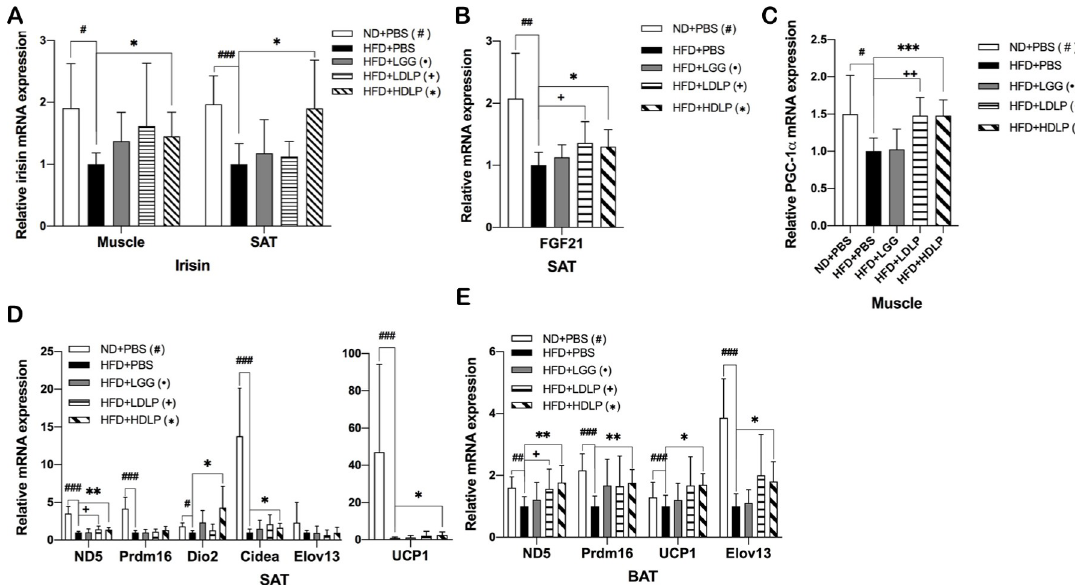
Fig 3. L . plantarum treatment induces browning and non-shivering thermogenesis. Effects of L . plantarum treatment on mRNA expression of (A) irisin in skeletal muscle, (B) FGF21 in SAT, (C) PGC-1 α in skeletal muscle, and (D-E) genes involved in browning and thermogenesis in SAT and BAT. Adipose tissue genes are normalized to expression of β -actin, skeletal muscle genes are normalized to expression of Arbp. Data present mean ± SD for 7~8 mice in each group. Student’s two-tailed t-test was used for analysis of differences between groups. #, •, +, � p < 0.05, ##, ••, ++, �� p < 0.01, ###, •••, +++, ��� p < 0.001.